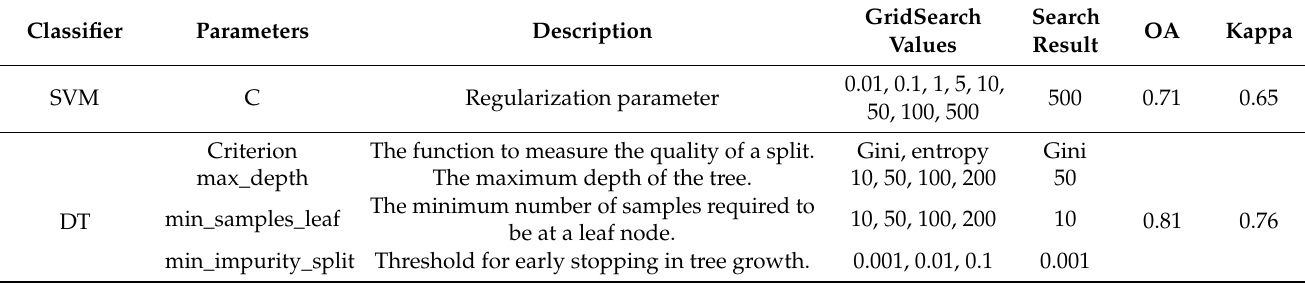
Table 2. The optimal hyperparameters settings and highest accuracy for SVM, DT, RF, and